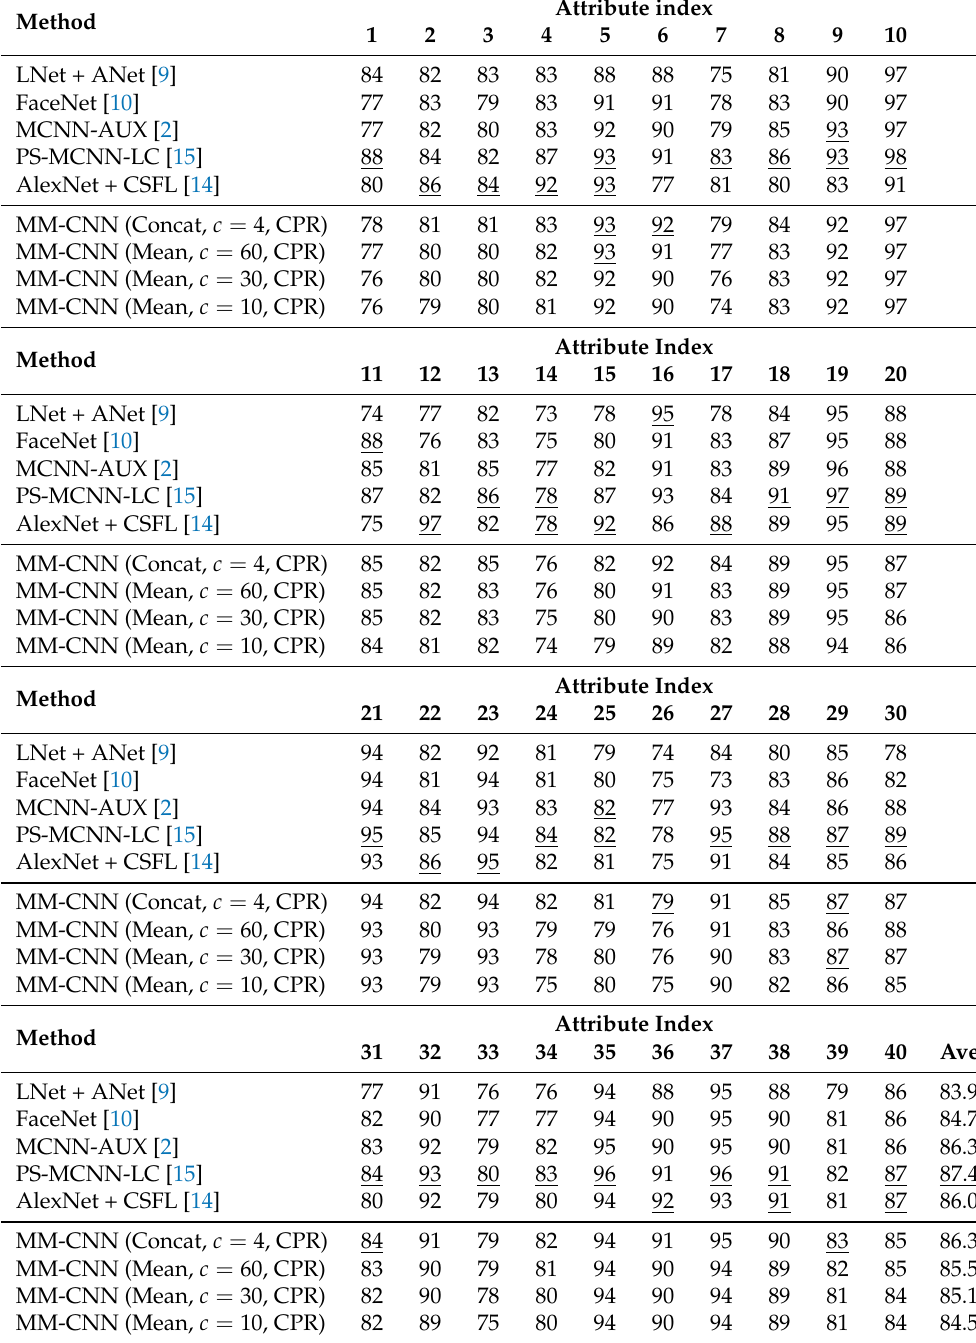
Table 9. Estimation accuracy of face attribute estimation methods for LFW-a. Best accuracy is shown with